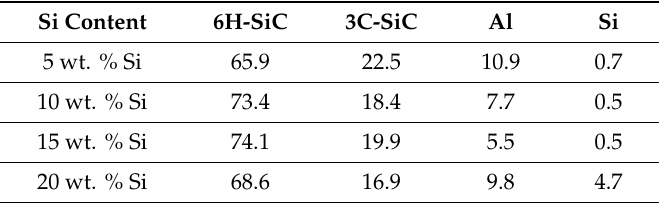
Figure 6. Line sketch of SiC with transition layer from point A to point B ( a ). EDS line scanning analysis of the transition layer ( b ). Table 3. Volume fraction (vol.%) of central